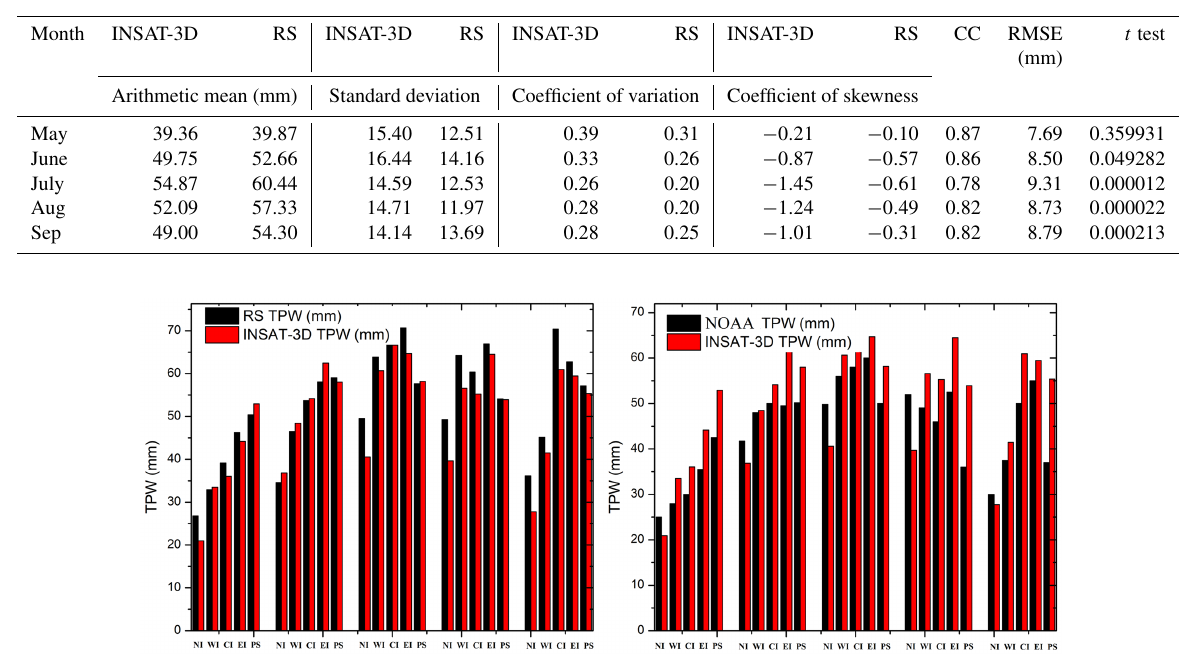
Table 2. Statistics and correlation between total precipitable water measured by INSAT-3D and RS.